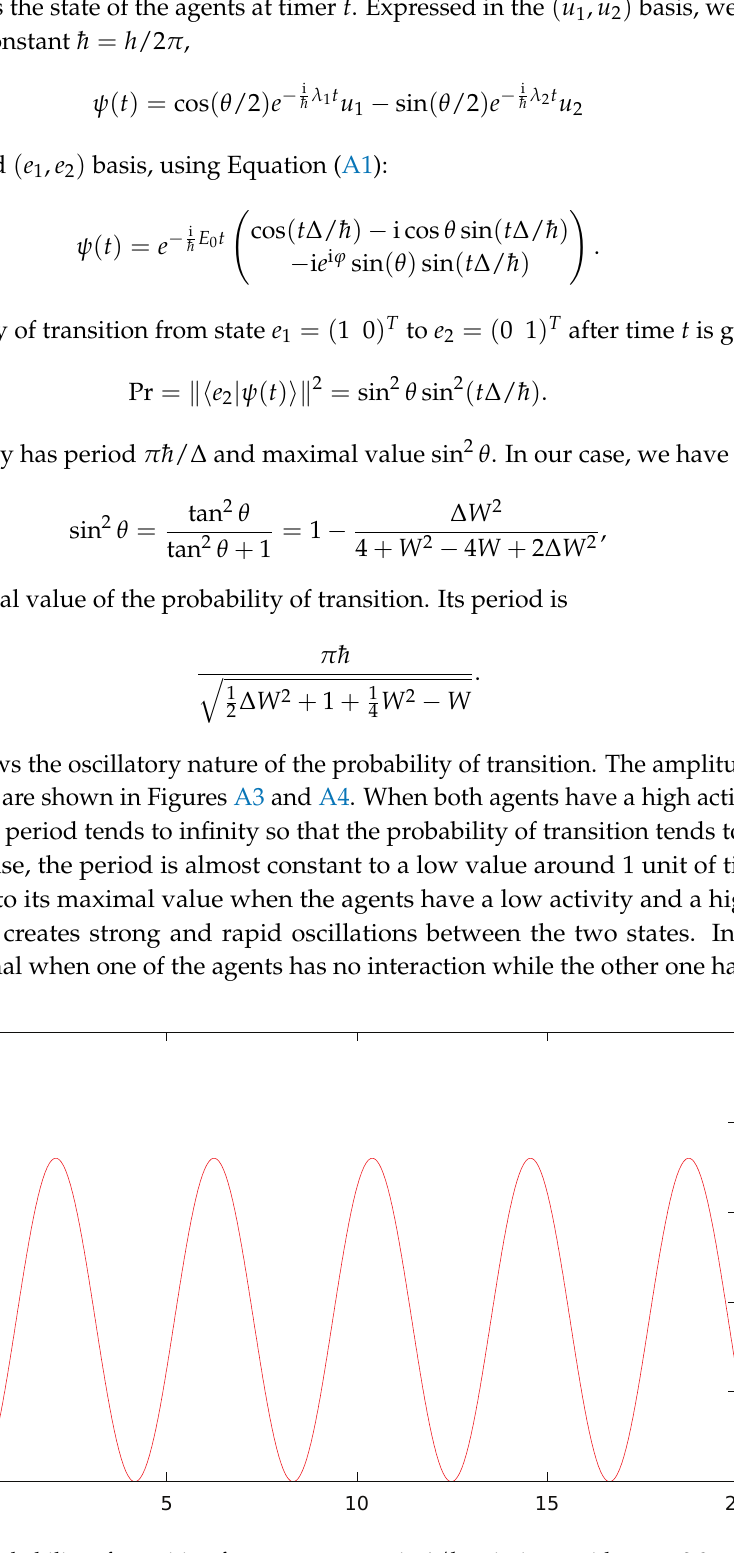
Figure A2. Probability of transition from state e 1 to e 2 in 1/¯ h unit times with w 1 = 0.9, w 2 =